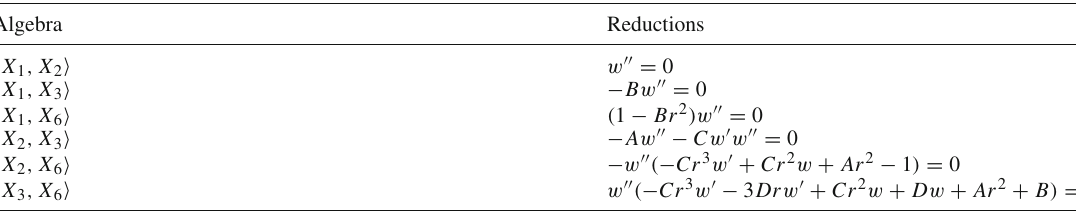
Table 2 Reductions of Eq. (6) Algebra